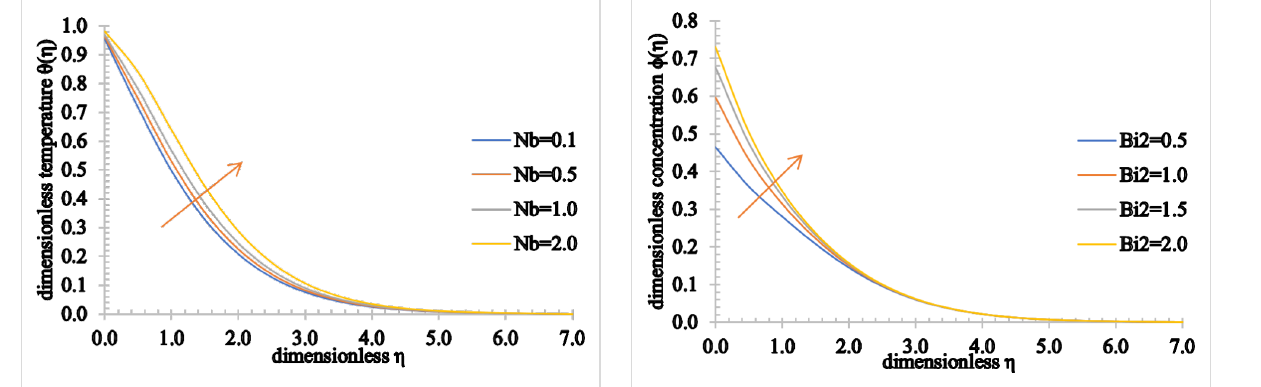
Figure 20: The temperature profile for increasing values of Nb .